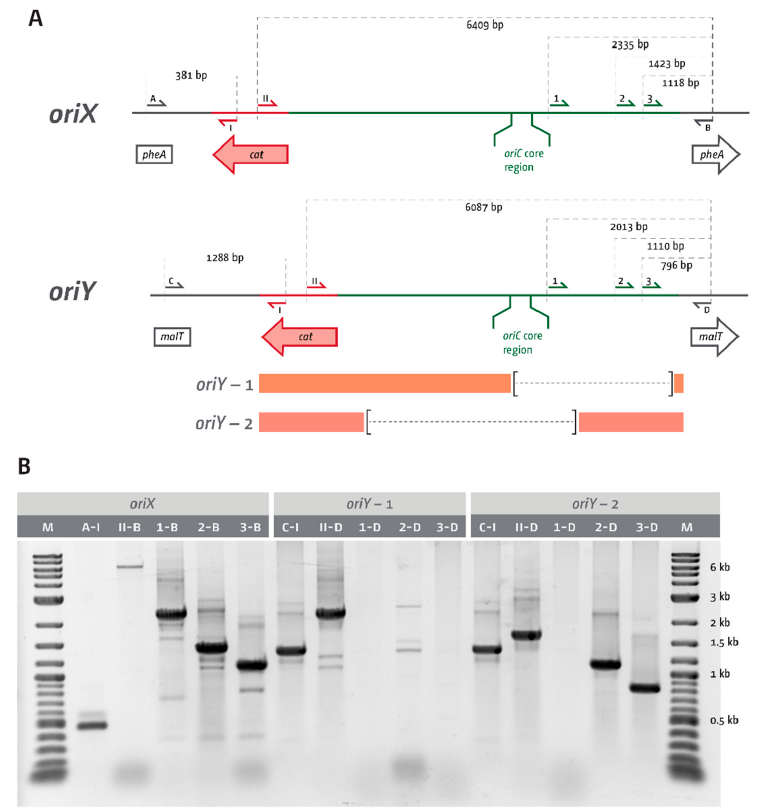
Figure 2. PCR confirmation of oriX and oriY integration cassettes into the chromosome. ( A ) Schematic representation of the integration region following successful integration of oriX into pheA or oriY into malT , respectively. Primers are identified according to their position with letters, numbers, or roman numerals. Primer binding sites are indicated. The orange bars below the oriY scheme indicate the likely regions where truncation has taken place, taking into consideration the overall length of the integrated region, as well as the presence and absence of defined primer binding sites, as shown in ( B ). The dashed lines represent the approximate sizes of truncations. ( B ) Agarose gel electrophoresis of PCRs with primers highlighted in ( A ) on templates in which either oriX or oriY is integrated into the chromosome. Sizes of relevant marker fragments (2-log kb ladder, NEB) are indicated. The primer combinations used for the individual PCRs are given directly above the relevant lane (primers A and I shown in ( A ) are given as A-I). An inverted gel image is shown for clarity.